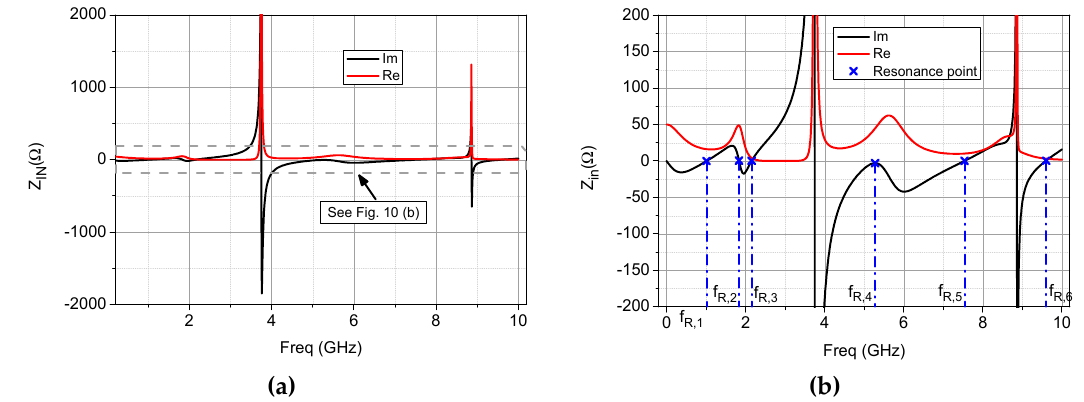
Figure 10. The input impedance of the SIR hairpin resonant filter. ( a ) Global view and ( b ) Partial